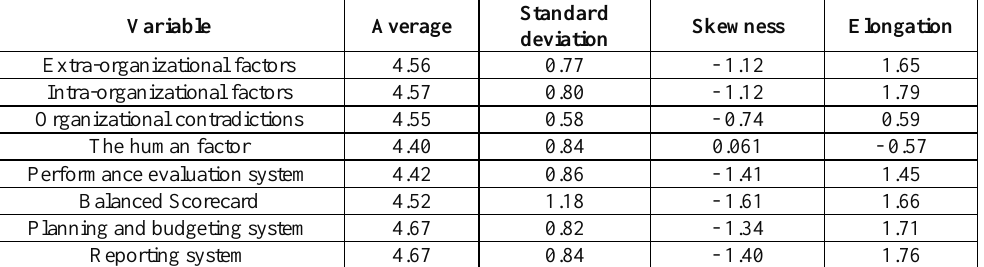
Table 3. Descriptive indicators of research